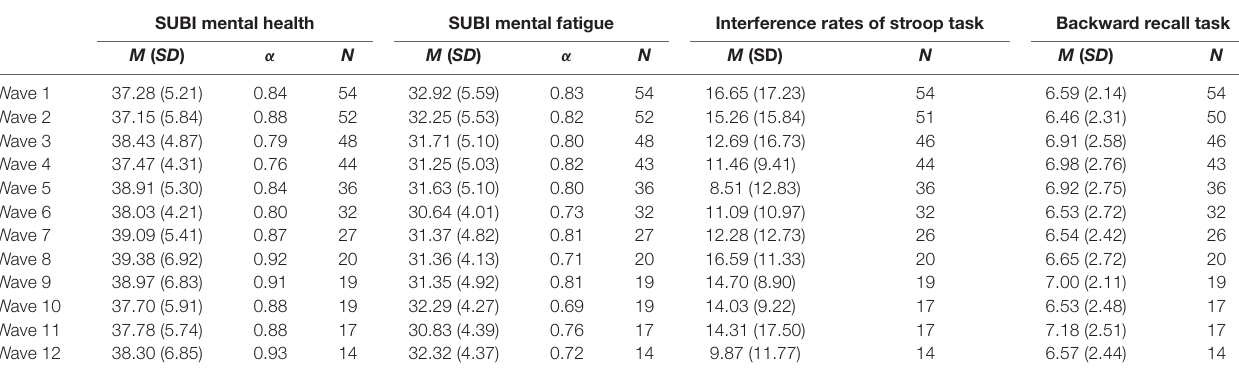
TABLE 1 | Descriptives statistics of key variables reported in the manuscript. SUBI mental health SUBI mental fatigue Interference rates of stroop task Backward recall